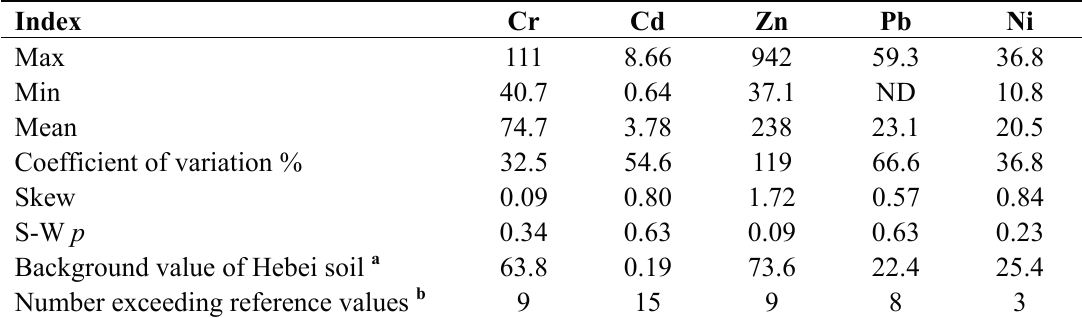
Table 2. Heavy metal concentrations in Yanghe River sediments